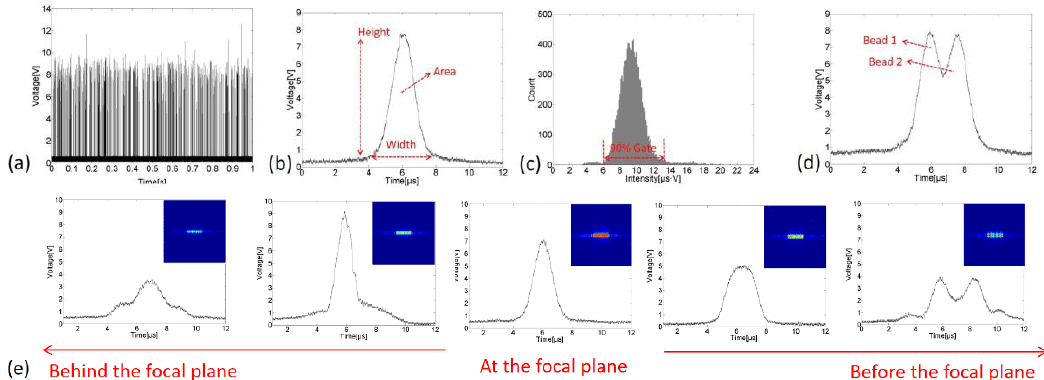
Figure 8. Fluorescence signals captured by the microflow cytometer system, ( a ) signals emitted from 5 µ m beads during 1 s time windows, ( b ) signal waveform of a 5 µ m bead, ( c ) a typical intensity histogram of 5 µ m beads, ( d ) the adhesion of two beads could be recognized according to its fluorescence signal, ( e ) the signal waveform deformed when the sample flow was before or behind the focal plane, with the corresponding light intensity distributions shown in insert graphs, and it shows that at the focal plane the spot displayed the best homogeneity and most accurate dimensions.